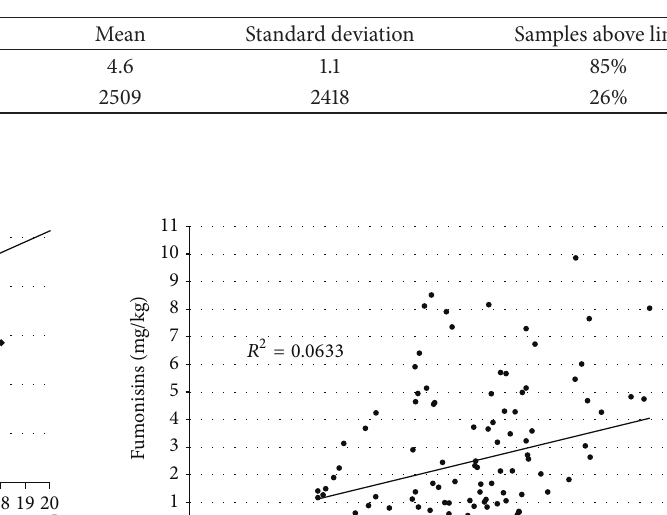
Table 3: Ergosterol and fumonisins content of 117 maize samples.